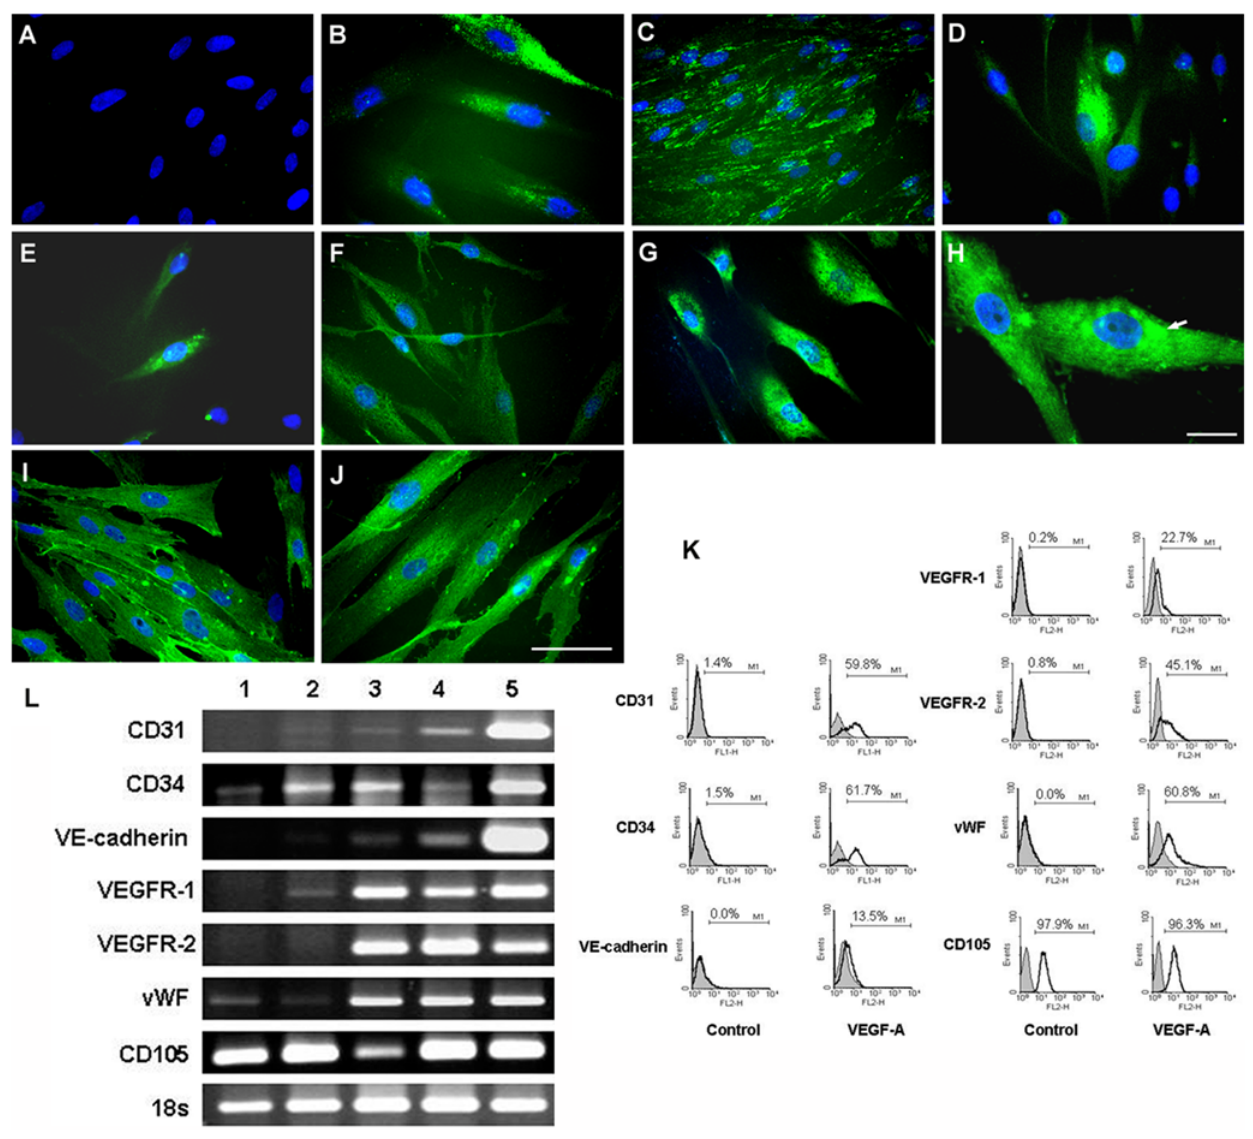
Figure 2. Characterization of human placental multipotent mesenchymal stromal cells (hPMSCs) after inducing differentiation into endothelial cells. Immunofluorescence staining of CD31 in undifferentiated hPMSCs is shown in (A) as a negative control. Immunofluorescence of endothelial markers in differentiated hPMSCs under induced culture conditions: (B) CD31, (C) CD34, (D) VE-cadherin, (E) VEGFR-1, (F) VEGFR-2, (G) von Willebrand factor, (H) von Willebrand factor under high magnification (Scale bar: 1 m m); Weibel-Palade bodies were visible within the differentiated hPMSC cytoplasm (arrow). CD105 was positive in (I) undifferentiated hPMSCs and (J) hPMSCs differentiated into endothelial cells. Cell nuclei were counterstained with DAPI. Scale bar: 10 m m. (K) Flow cytometry analysis of endothelial cell markers on the hPMSC surface before and after differentiation induced by VEGF-A. (L) mRNA for endothelial cell markers was amplified from 2 different strains of undifferentiated hPMSCs (lane 1 and 2) and hPMSCs differentiated into endothelial cells (lane 3 and 4). mRNA from human umbilical vein endothelial cells was used as a positive control (lane 5). The data shown are representative of 3 different experiments. doi:10.1371/journal.pone.0006913.g002 b Fibronectin and integrin a promote VEGF-A-induced 5 1 differentiated hPMSC adhesion and migration Since integrin a 5 b 1 is a specific receptor for fibronectin, and angiogenesis often involves endothelial cell adhesion and migration within a fibronectin-rich ECM, we investigated the ability of differentiated cells to interact with fibronectin. As the cells also express integrins a v b 3 and a v b 5 , vitronectin was used as a control ligand. Differentiated hPMSCs adhered to fibronectin more efficiently than to vitronectin (P , 0.001). VEGF-A significantly increased the adhesion of VEGF-A (50 ng/ml) or fibronectin (50 m g/ml) alone, but the